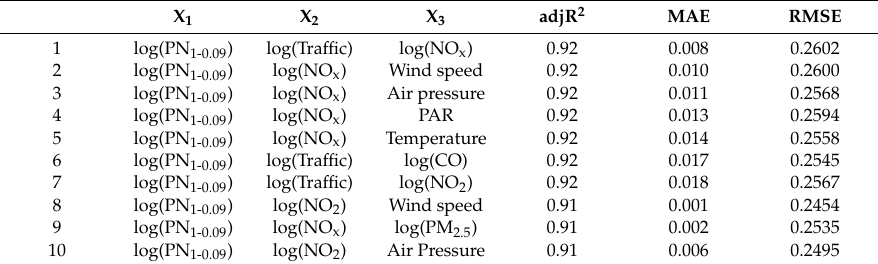
Table 6. Top ten best models in street canyon Mäkelänkatu winter